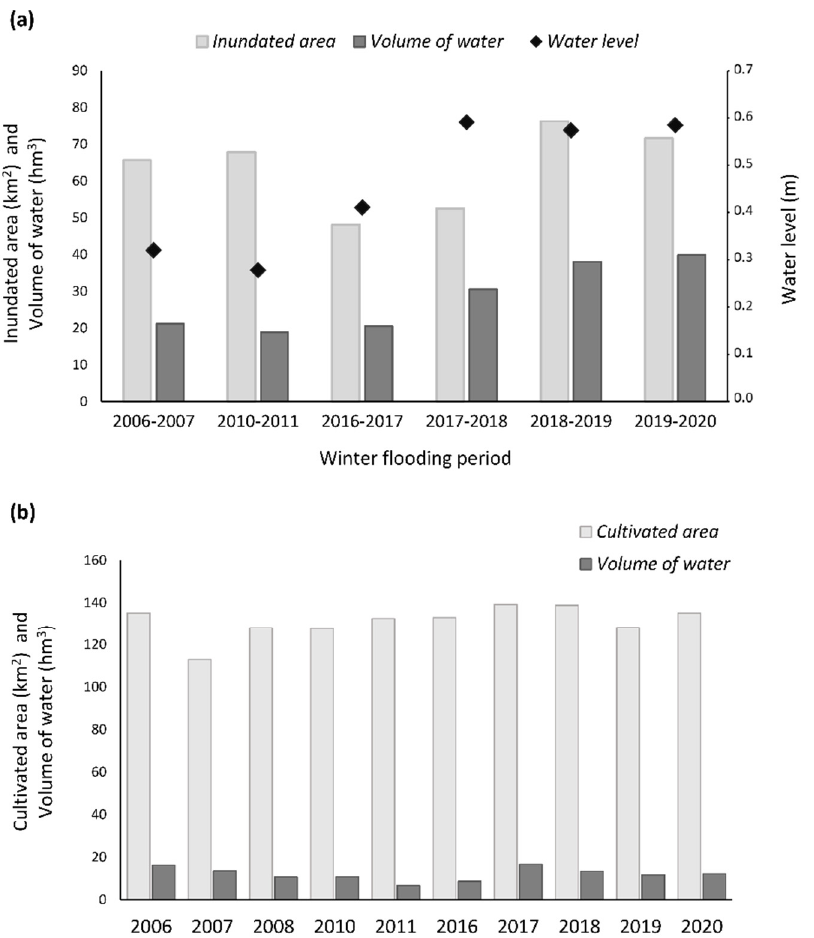
Figure 5. ( a ) Comparison of Landsat-derived average flooded area and water volume values in the rice fields of the Natural Park of Albufera together with water level values obtained during the winter flooding periods studied (from November to February); ( b ) Annual monitoring of the rice cultivation period in the Natural Park of Albufera using the average values of cultivated area and volume of water obtained from the processed Landsat images corresponding to the months of July and August.